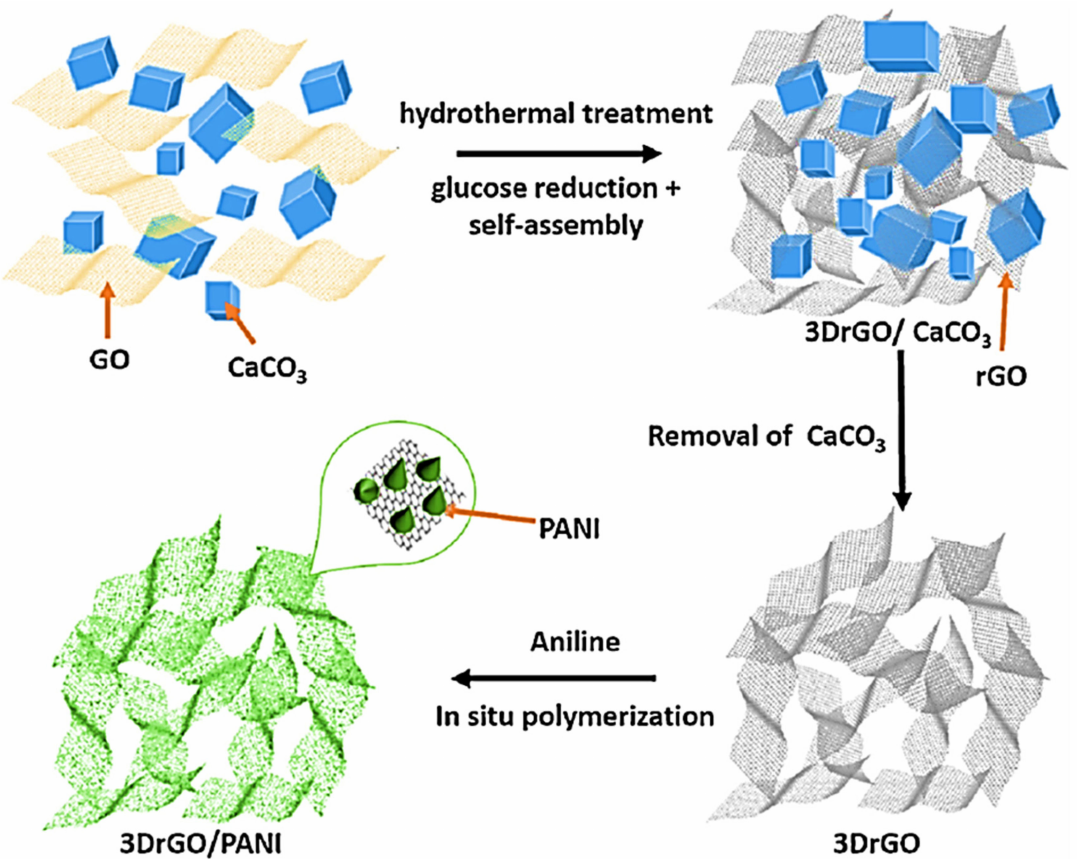
Figure 3. Preparation scheme of three dimensional reduced graphene oxide (3D-rGO) and three dimensional reduced graphene oxide/polyaniline (3D-rGO/PANI). GO = graphene oxide; PANI = polyaniline. Reprinted with permission from Ref. [76]. 2015,